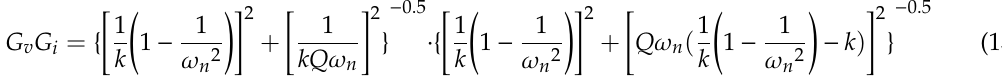
Figure 3. Current gain 𝐺 𝑖 according to load quality factor and 𝜔 𝑛 (K = 1, K = 0.2).